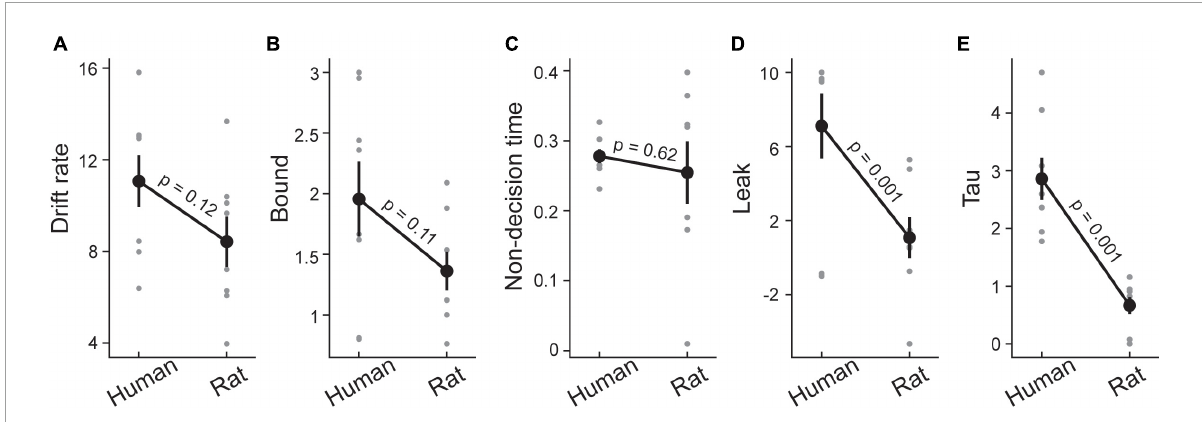
FIGURE3 Drift diffusion model in rats and humans. Five parameters of drift diffusion including drift rate (A) , decision threshold or bound (B) , non-decision time (C) , leak (D) , and collapsing bounds or tau (E) illustrated for rats and humans. Gray circles show each parameter for individual subjects and black circles depict the average of each parameter across subjects. Error bars indicate ± SEM across